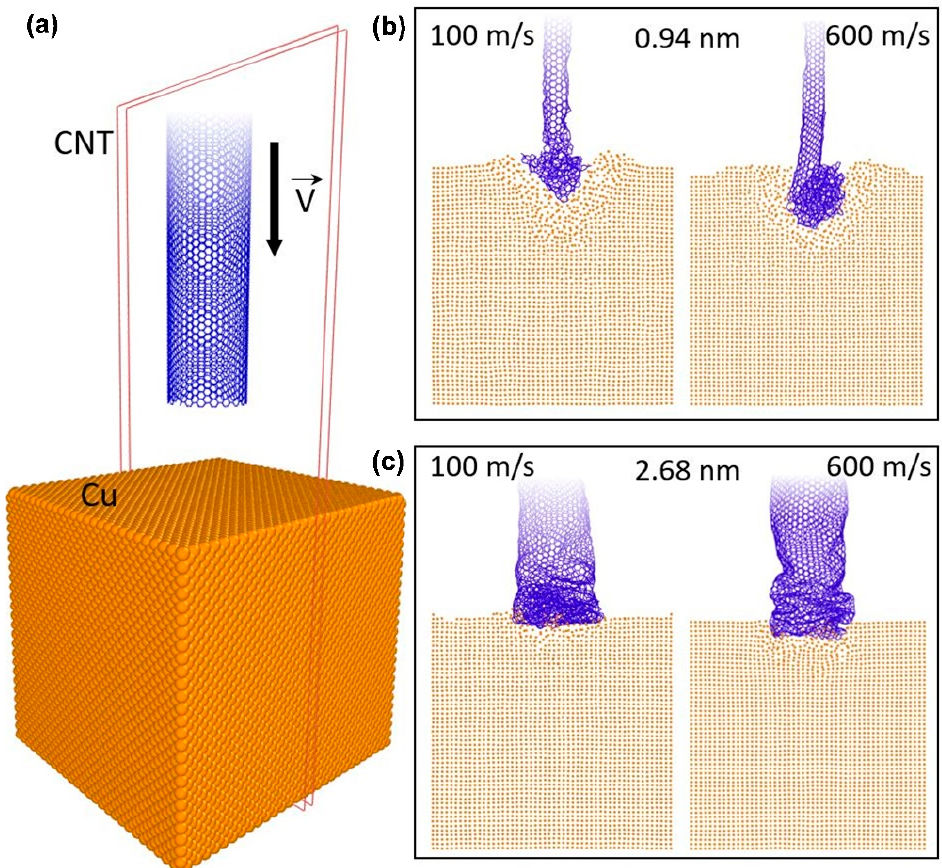
Figure 4. Schematic presentation of the molecular dynamic simulation. ( a ) Presentation of the CNT deposition into the copper substrate. ( b ) Interaction of CNT with a diameter of 0.94 nm with copper substrate at the acceleration rate of 100 and 600 m/s. ( c ) Interaction of CNT with a diameter of 2.68 nm with copper substrate at the acceleration rate of 100 and 600